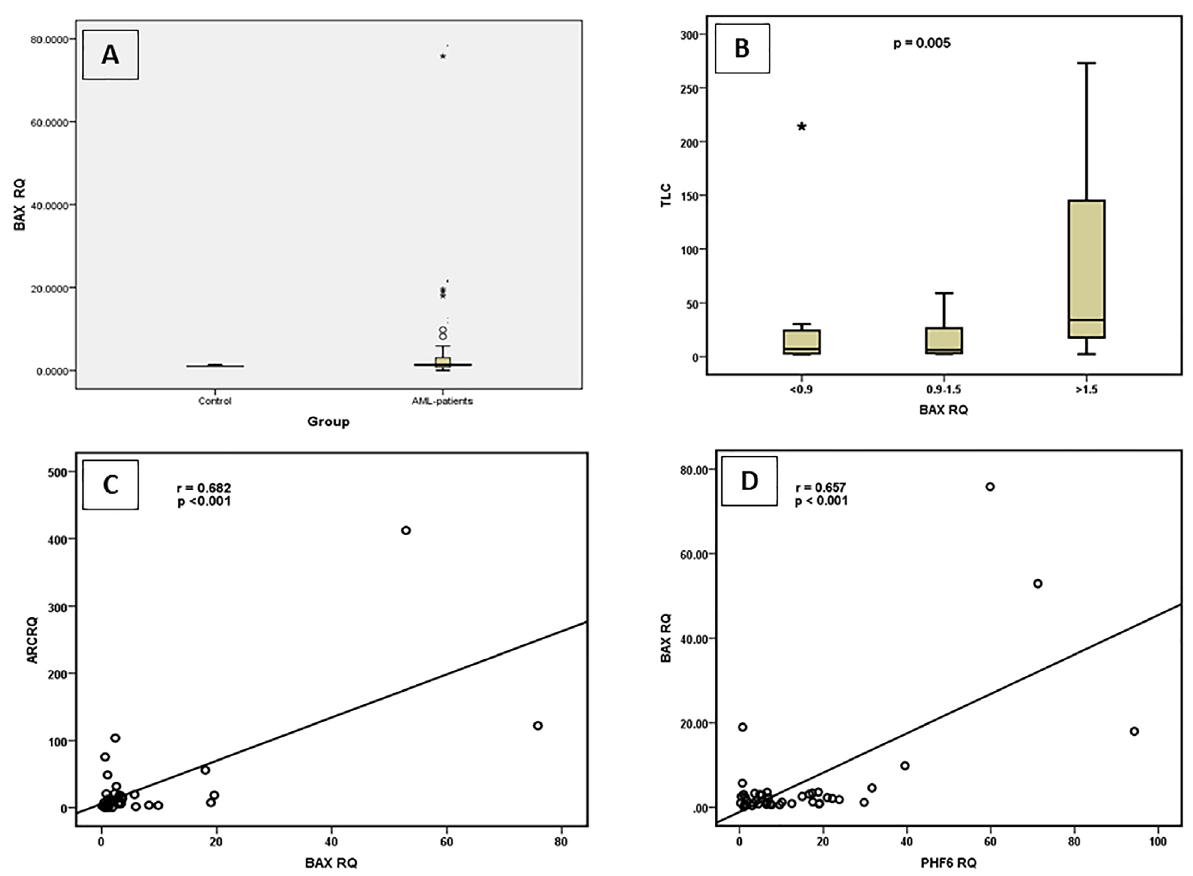
Figure 4 - Significance of BAX expression. BAX expression levels, represented as RQ value, in AML patients and in Control groups (A). Correlation between BAX expression and TLC (B). Correlation between BAX expression and ARC expression (C). Correlation between BAX expression and PHF6 expression (D).